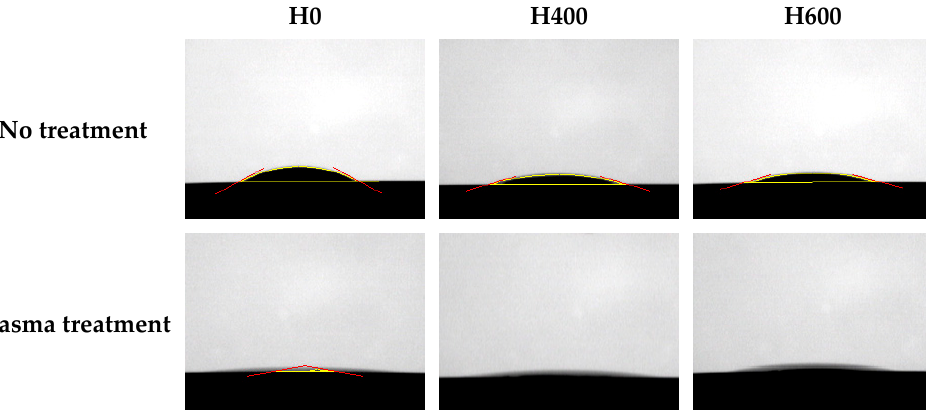
Figure 1. The water contact angle of the samples. The yellow line indicates the solid-liquid interface and the liquid-fluid interface. The red line indicates the contact angle.